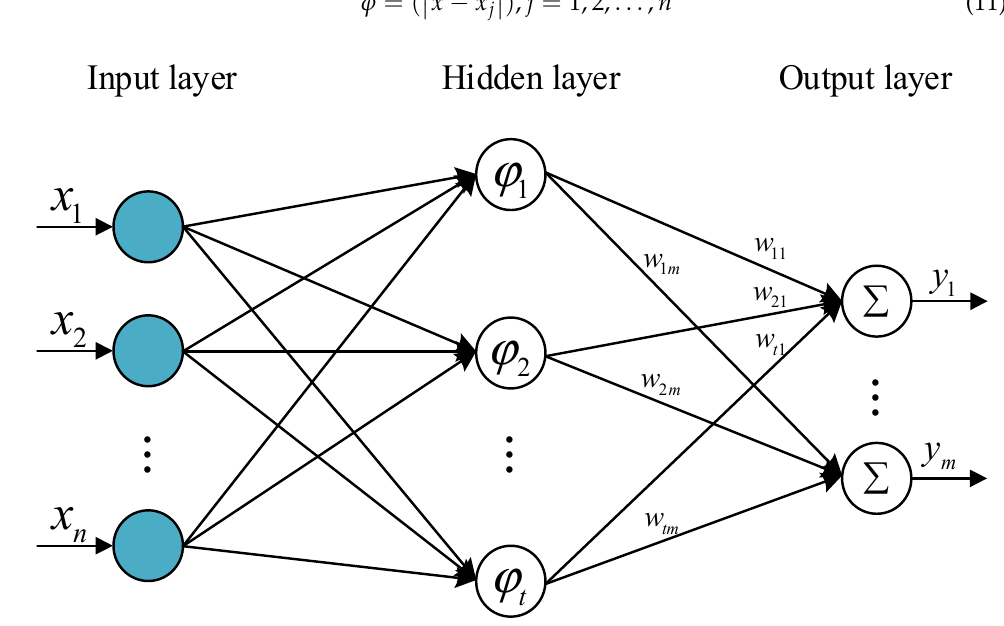
Figure 8. RBF neural network structure.